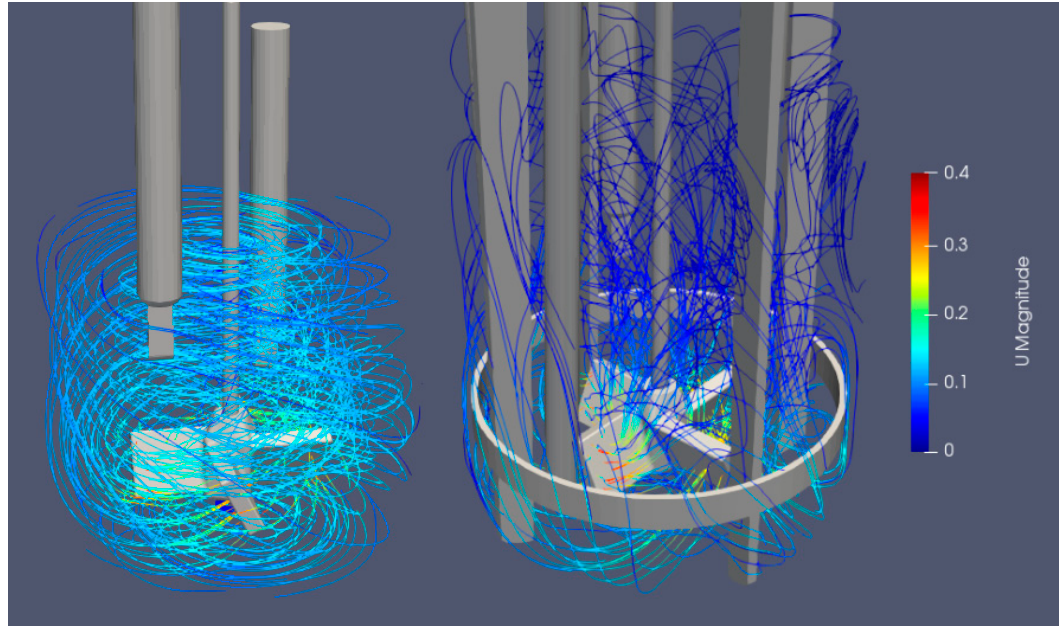
Figure 8. Comparison of streamlines for two experiments. B (right) is 1.5 L full with baffles and E (left) is 1 L full without baffles. is 1 L full without ba ffl